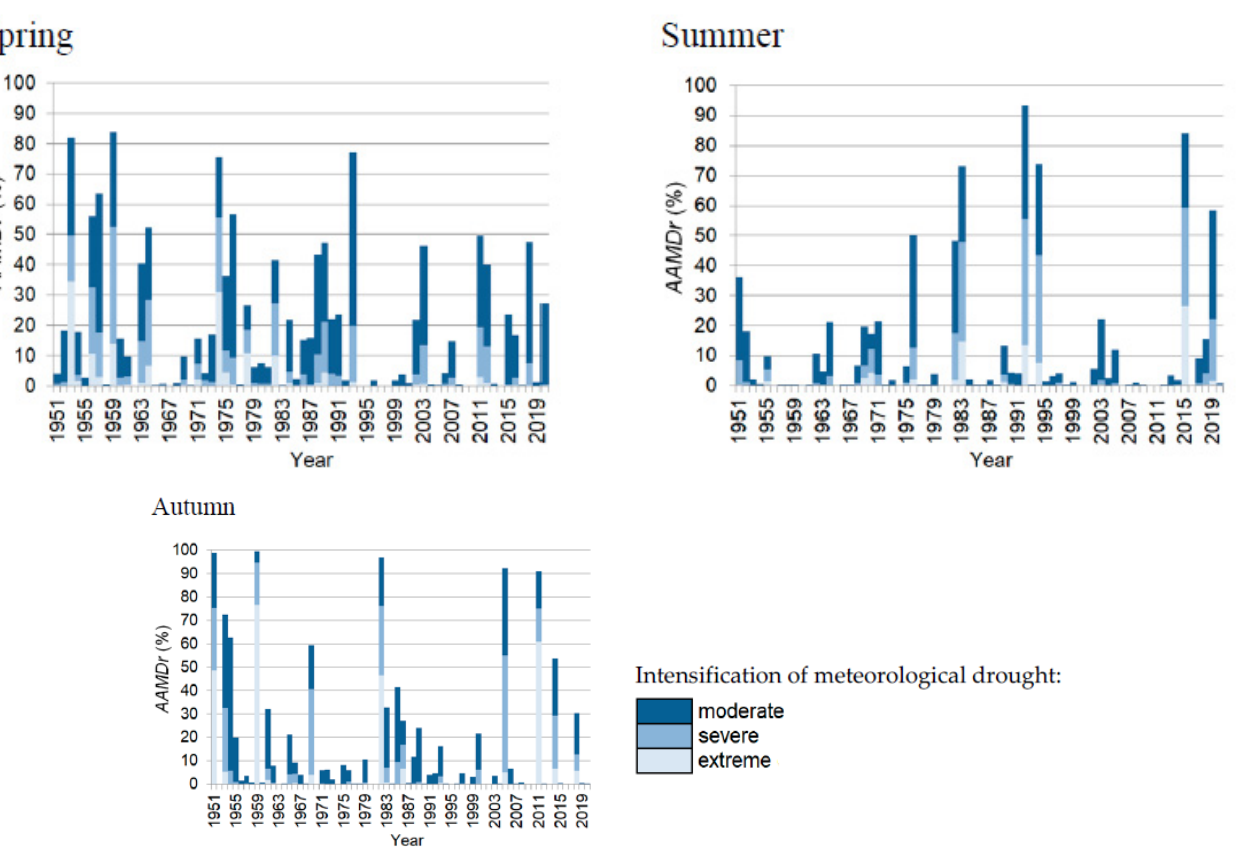
Figure 8. Variations in Poland’s area affected by meteorological drought ( AAMDr ) of varying inten- sity, determined based on SPI-3 in spring, summer and autumn. Years 1951–2020.